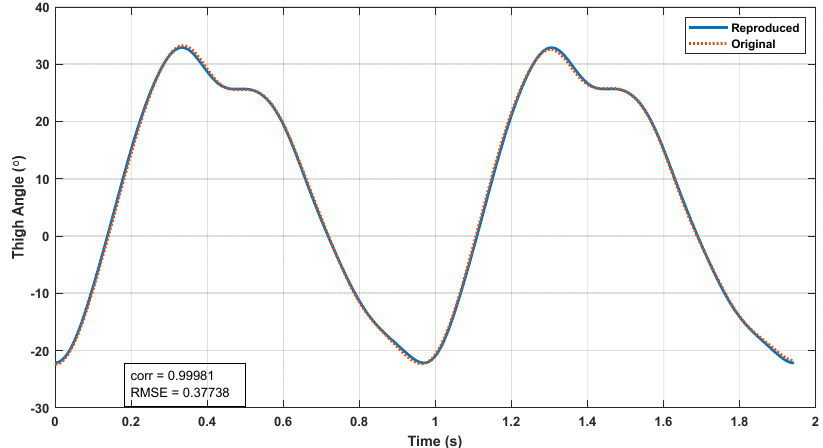
Figure 6. Original and reconstructed thigh angle waveforms of a sample trial.